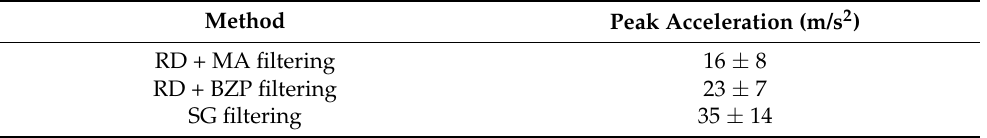
Table 7. Peak acceleration values for the maximum height jump including a ± 2 σ uncertainty due to differentiation/filtering methods, evaluated according to reference signal tests in Table 6.